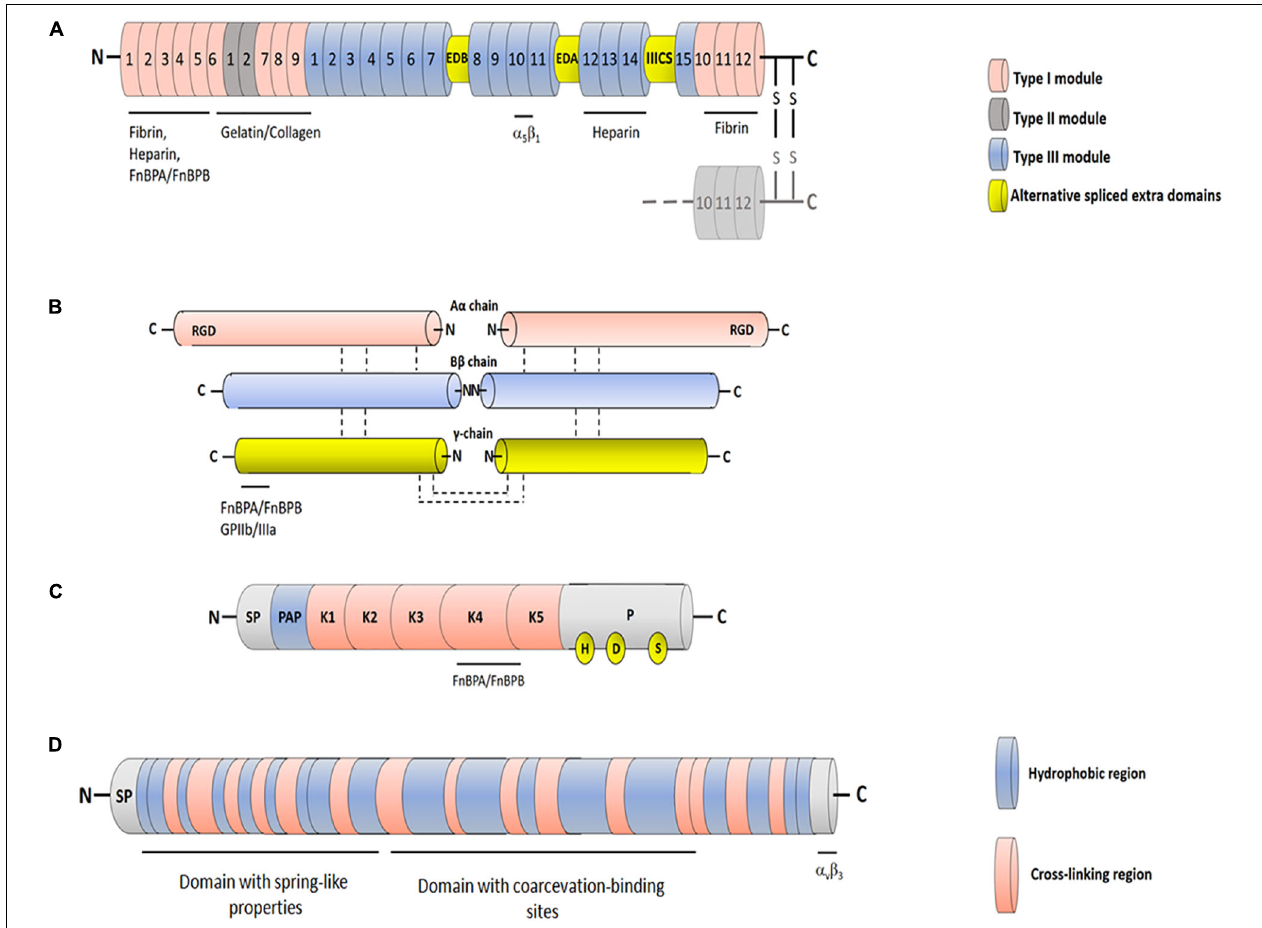
FIGURE 2 | Schematic representation of FnBPs ligands. (A) Fibronectin. Each Fn chain consists of three different types of modules with distinct folds: FnI, FnII and FnIII. Sets of adjacent modules form functional protease-stable domains, including the N-terminal domain, the gelatin-binding domain and the cell-binding domain. The cell-binding domain harbors the RGD motif within the 10th FnIII module and “synergy site” in the 9th FnIII module, both involved in interaction with integrin α 5 β 1 . Cellular Fn includes two variable proportions of alternatively spliced FnIII modules EDB and EDA (extracellular domains B and A) and one connecting segment (IIICS). Binding sites for different binding partners are indicated. (B) Fibrinogen. Fbg is composed of three pairs of non-identical chains named A α , B β and γ . The three chains are connected by disulfide bonds and are in hand to hand conformation forming a central E domain from which fibrinopetides A and B are released by the action of thrombin. The E domain is connected to the C-terminal D domains by coiled-coil region. The C-terminus of the γ chain includes the binding sites for integrin GPIIb/IIIa and FnBPA and FnFPB. (C) Plasminogen. Circulating Plg comprises at the N-terminal end a signal peptide (SP) and a preactivation region (PAP) followed by five consecutive disulphide-bonded kringle domains (K1-K5) and a serine protease domain (P). The K4 domain is supposed to be the binding site for FnBPs. The catalytic triad in the protease domain formed by residues His 603 , Asp 646 and Ser 741 is also reported. (D) Tropoelastin. Tropoelastin is a protein comprising a signal peptide (SP) followed by alternating hydrophobic and cross-linking regions. The protein is functinctinally composed of an N-terminal domain that confers spring-like properties to the molecule and a C-terminal domain recognizing the α v β 3 integrin. The domains are connected by a bridge region that contains sites for the coarcevation